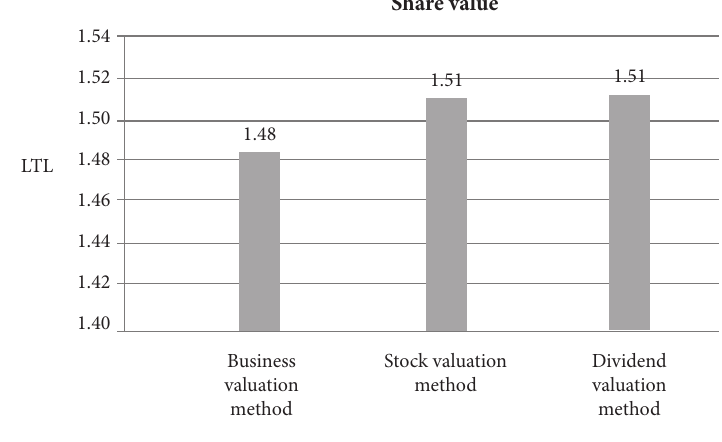
Fig. 3. TEO LT, AB share valuation